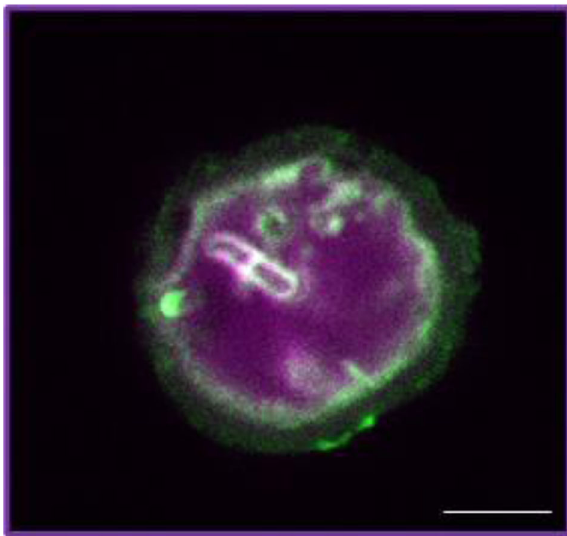
Fig. 6 Confocal microscopy image of B. cereus 4B at the fourth stage of the growth (52 h after inoculation). DNA was stained with 7AAD (pink color) and amyloid structures were stained with Thio fl avin T (green color). All scale bars correspond to 5 µm.